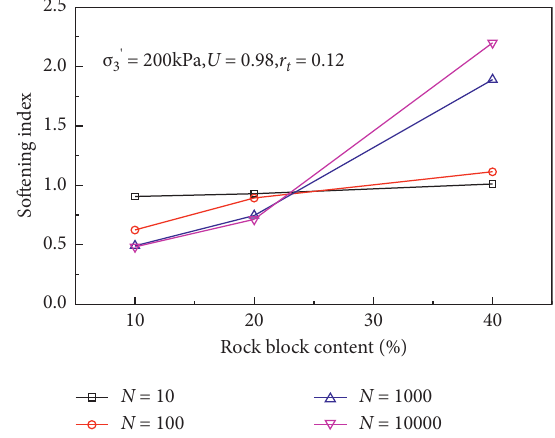
Figure 12: Curve of rock content and softening index under different number of